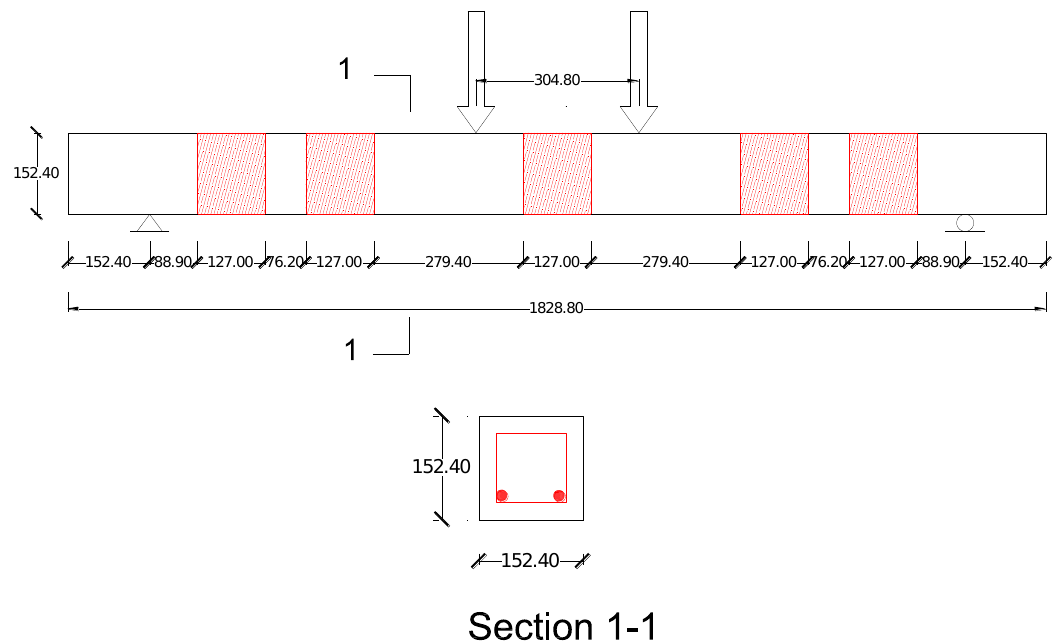
Figure 2. A typical test setup for a repaired reinforced concrete (RC) member (dimensions are in mm).